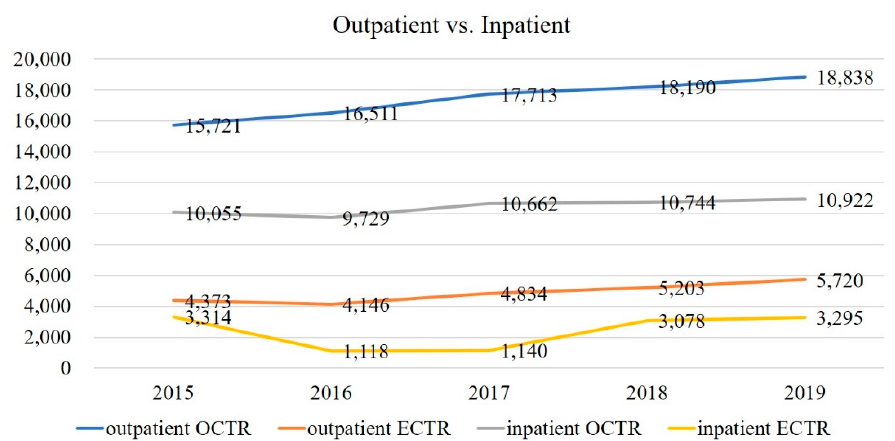
Figure 5. Trends in outpatient and inpatient surgeries, 2015–2019 (5 years). OCTR; open carpal tunnel release, ECTR; endoscopic carpal tunnel release.